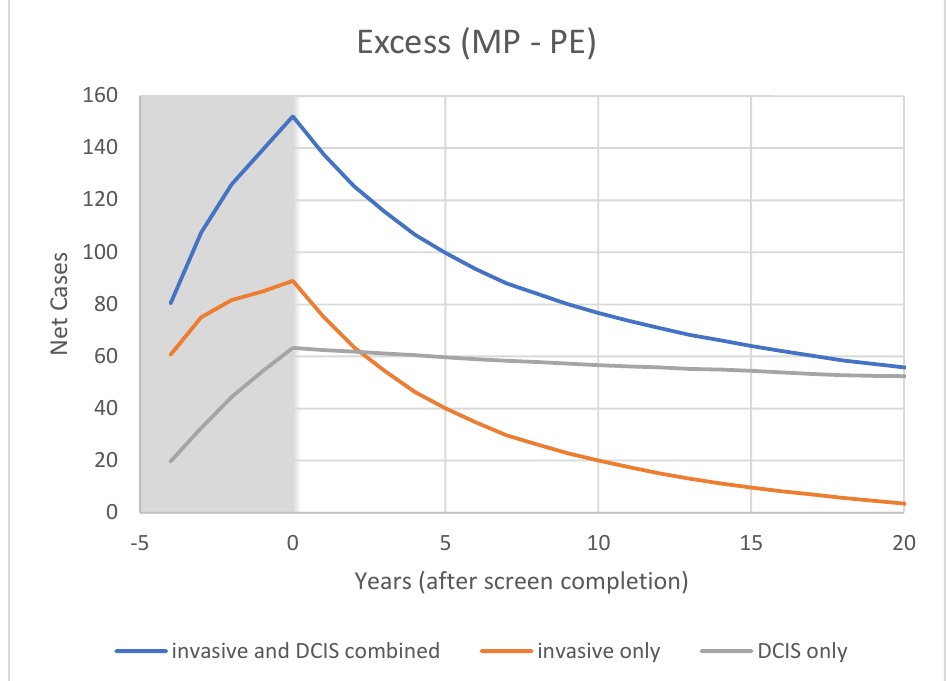
Figure 7. Modeled cumulative excess breast cancer detection in CNBSS2 from